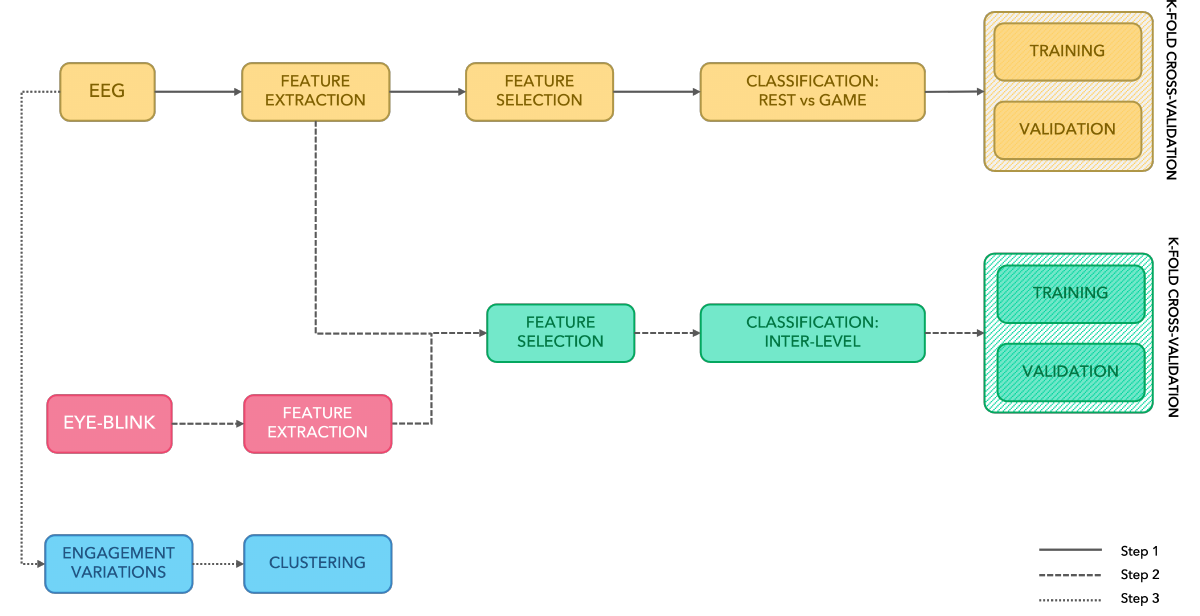
Figure 2. Offline data processing and analysis flowchart.